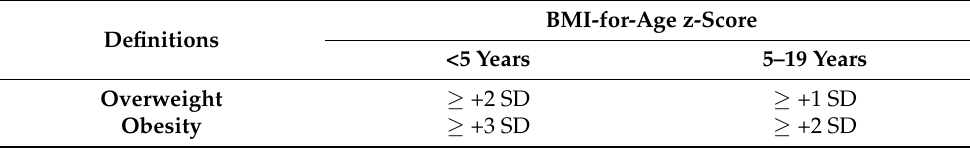
Table 1. Definitions to characterize BMI-for-age z-score in patients with